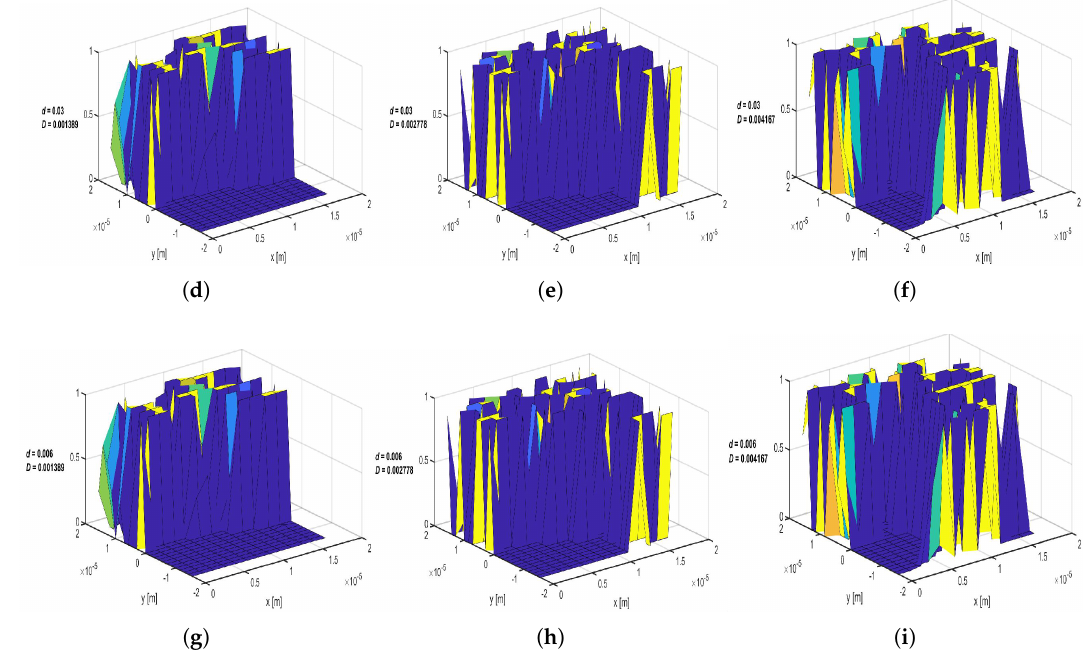
Figure A3. Concentration distribution within the porous media with variable linear drift ratio and dispersion coefficients correspond to ( a ) d = 0.2, D=0.001389 ( b ) d = 0.2, D = 0.002778 ( c ) d = 0.2, D = 0.004167 ( d ) d = 0.03, D = 0.001389 ( e ) d = 0.03, D = 0.002778 ( f ) d = 0.03, D = 0.004167 ( g ) d = 0.06, D = 0.001389 ( h ) d = 0.06, D = 0.002778 ( i ) d = 0.06, D = 0.004167 at a period of 10 days.